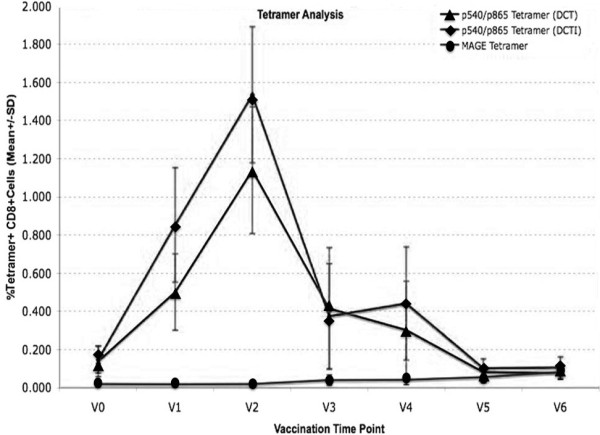
Tetramer+ CD8+ T cell responses (mean +/- SD) to only class I hTERT pulsed DCs. Vaccinations with DCT and DCTI in 10 patients. Both vaccines (DCT and DCTI) were equivalent in eliciting CD8+T cell responses and there were no statistically significant differences between DCT and DCTI at any vaccination time point (NS-not significant, p = 0.45, t-test). CD8+T cell tetramer+ response to an irrelevant HLA*A201 MAGE antigen, not used in the vaccination, was measured as a negative control; 150,000 events were acquired and analysed.